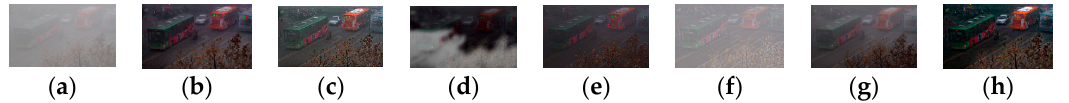
Figure 15. Qualitative comparison on dense haze image. ( a ) Dense haze image. ( b ) He et al.’s result. ( c ) Meng et al.’s result. ( d ) Ancuti et al.’s result. ( e ) Yu et al.’s result. ( f ) Tarel et al.’s result. ( g ) Choi et al.’s result. ( h ) Our result.